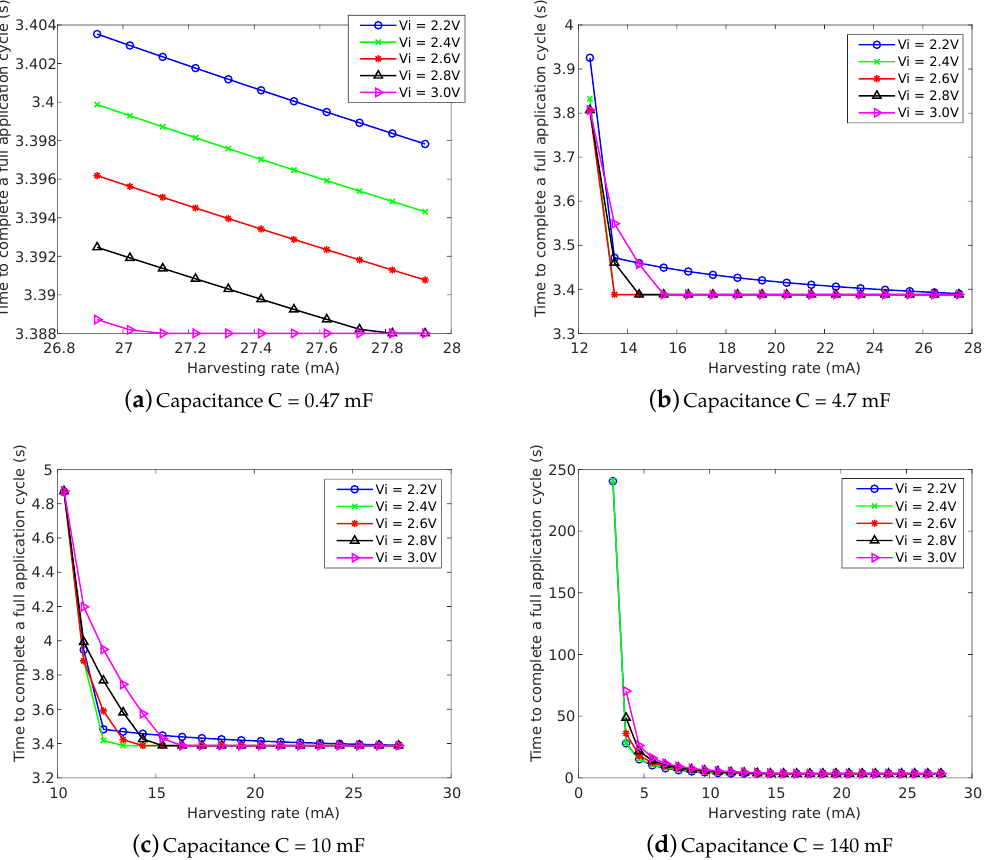
Figure 9. Full cycle time for different voltages and harvesting rates considering different capacitor sizes for the Sleep